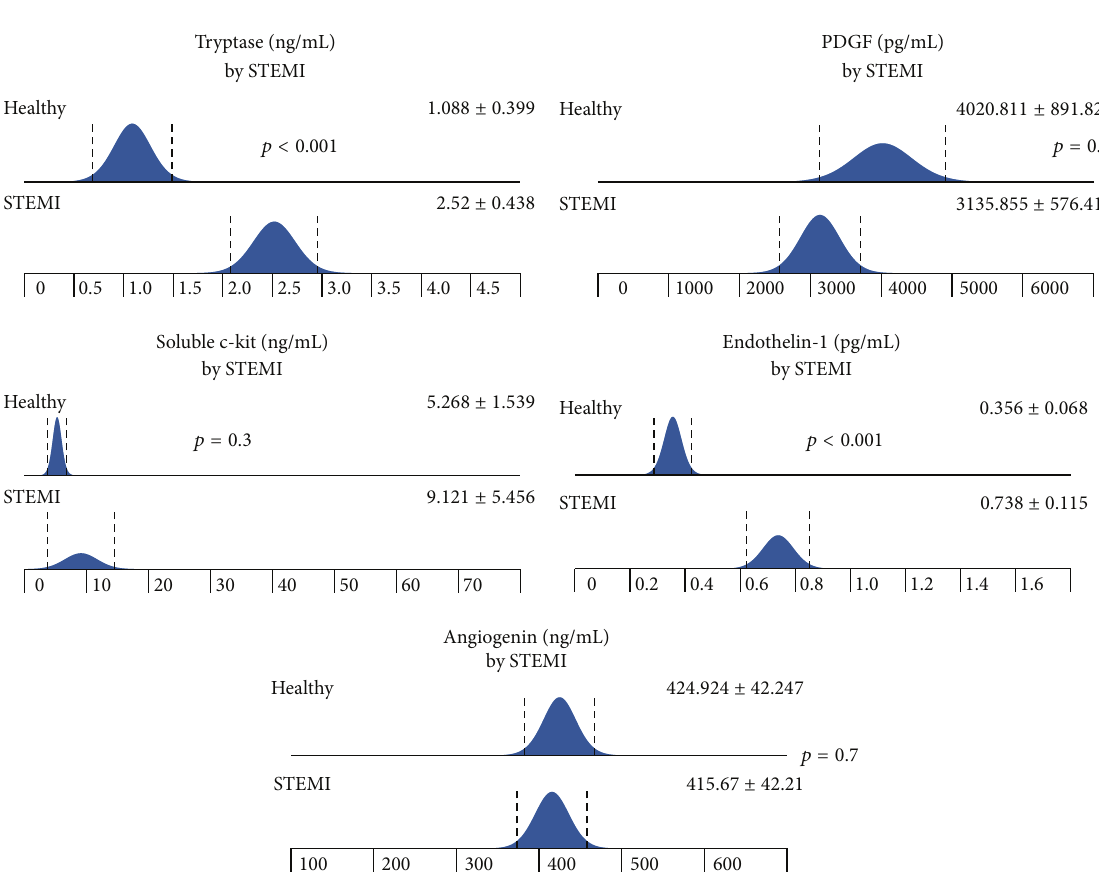
Figure 1: The differences in tryptase, PDGF, soluble c-kit, ET-1, and angiogenin levels between STEMI and healthy groups. The analysis was made using 𝑡 -test.